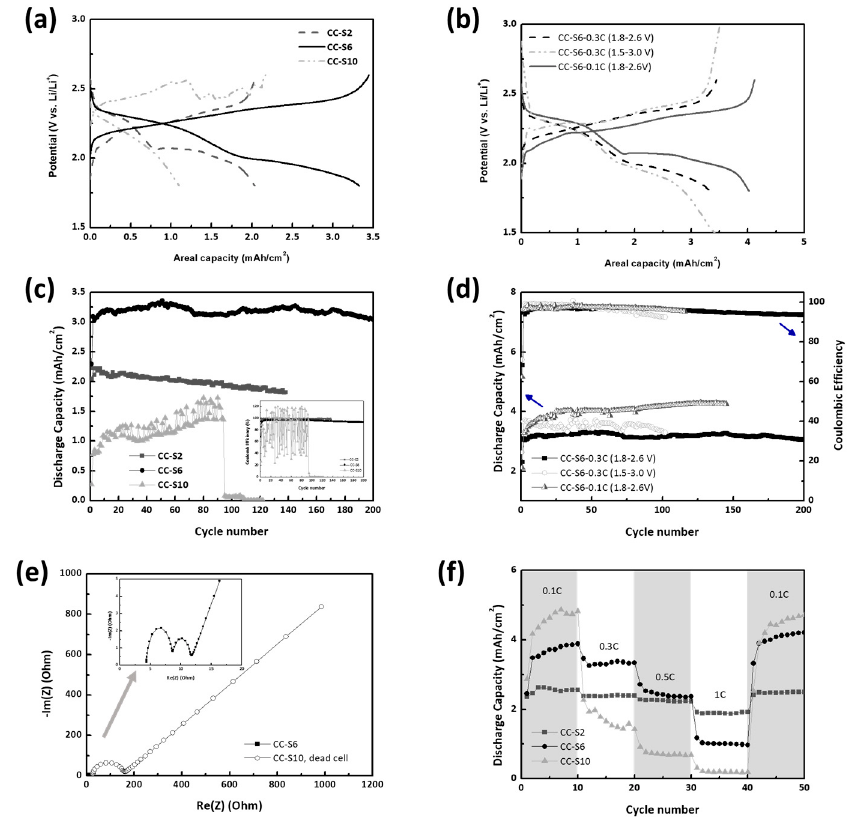
Figure 3. Charge/discharge profiles at the 50th cycle and cycle stability. ( a , c ) CC-S2, CC-S6, and CC–S10 operated at C/3 and ( b , d ) CC-S6 at C/3 and C/10 in the potential range of 1.8–2.6 and 1.5–3.0 V vs. Li/Li + ; ( e ) EIS spectra of CC-S6 and CC-S10 after GCPL cycling at C/3; ( f ) Rate capability of CC-S between C/10 and 1 C.